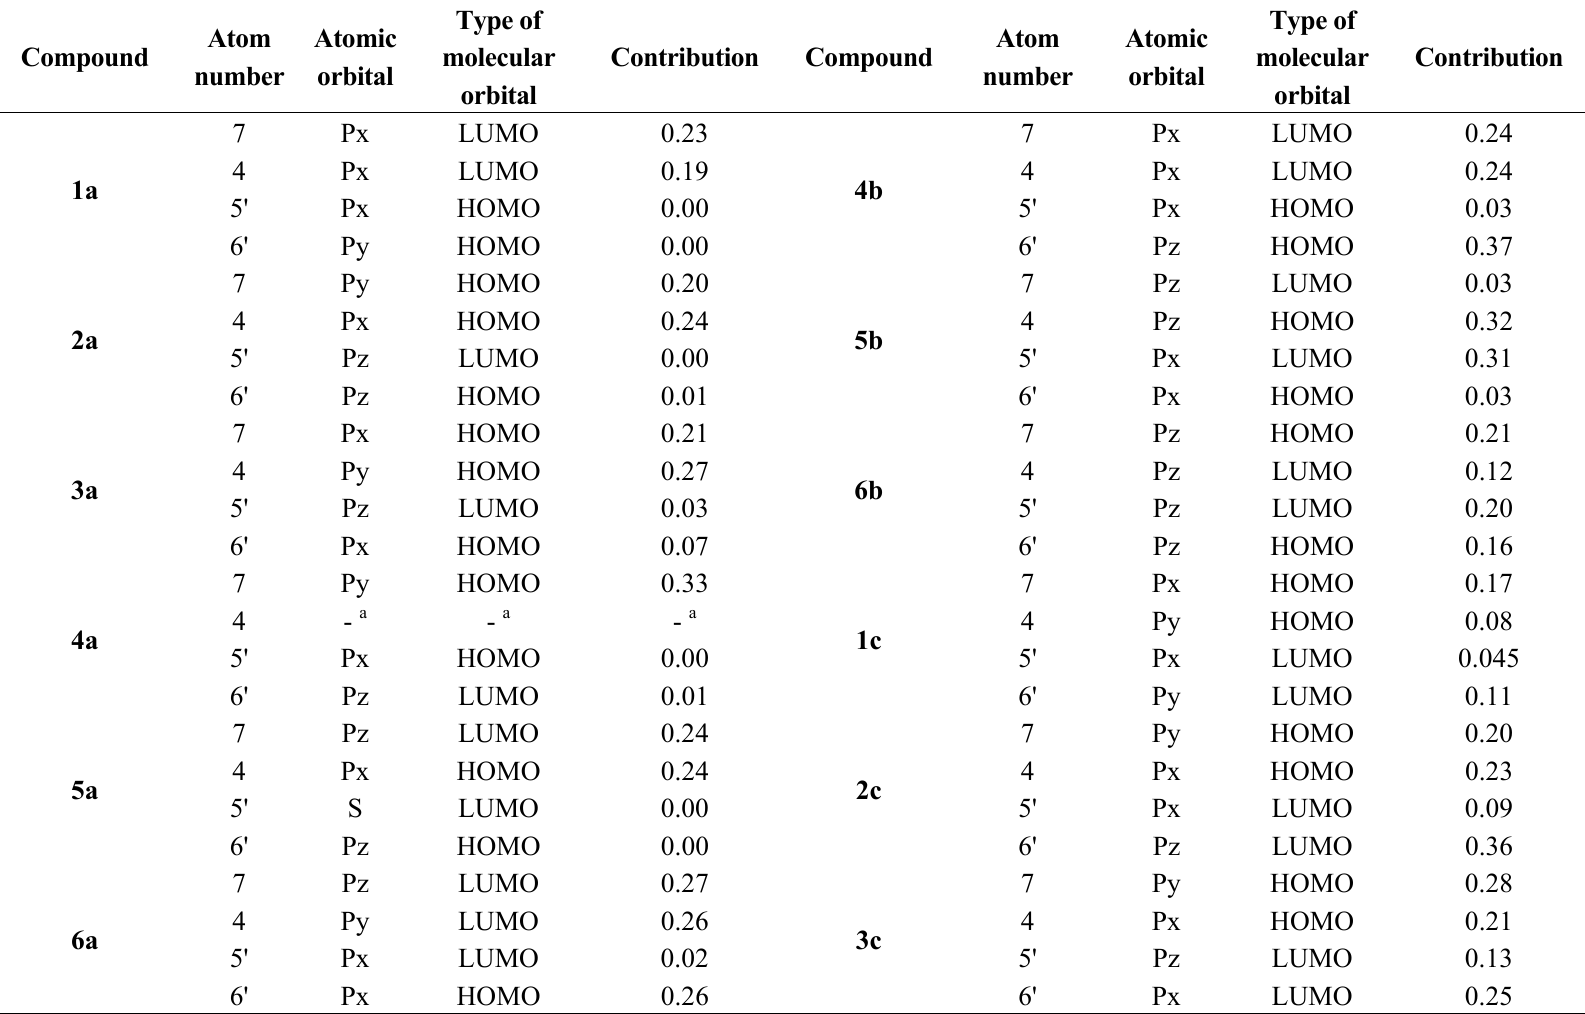
Table 3. Contribution of the most important atomic orbitals of carbon atoms in LUMO and HOMO (for atom numbers, see Figure 1).